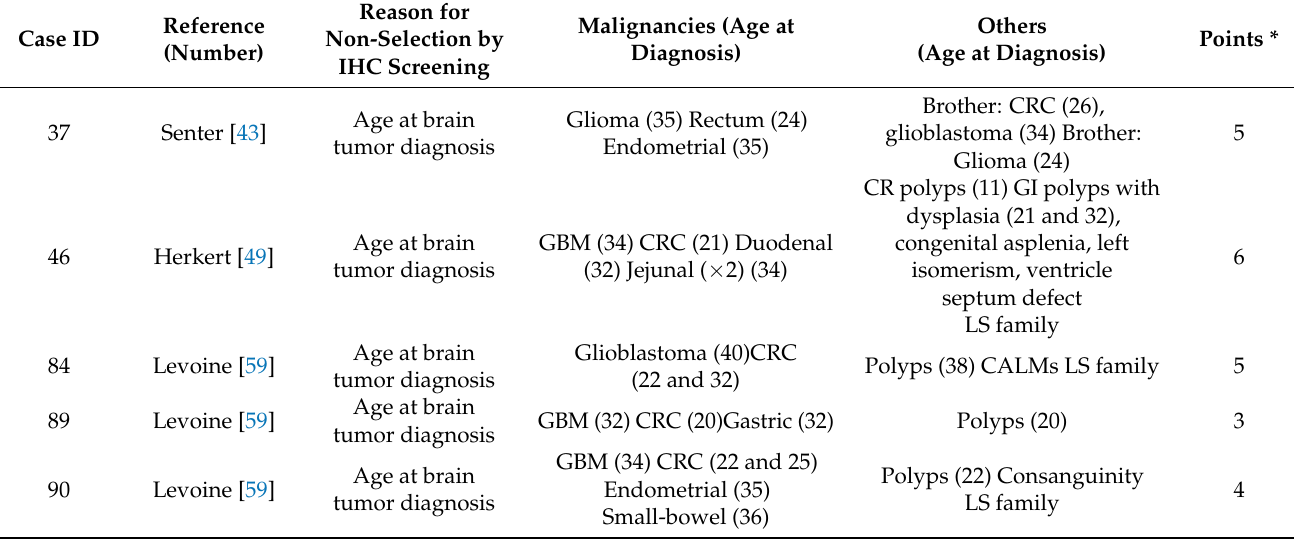
Table 5. Phenotypic features of patients who did not meet criteria for MMR IHC screening or had IHC false-negative results.